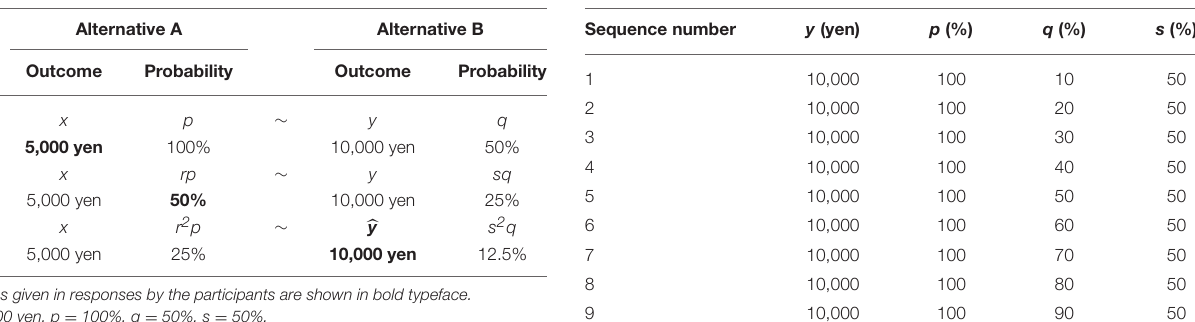
TABLE 1 | Verification process of projection invariance. TABLE 2 | Stimulation sequences of projection